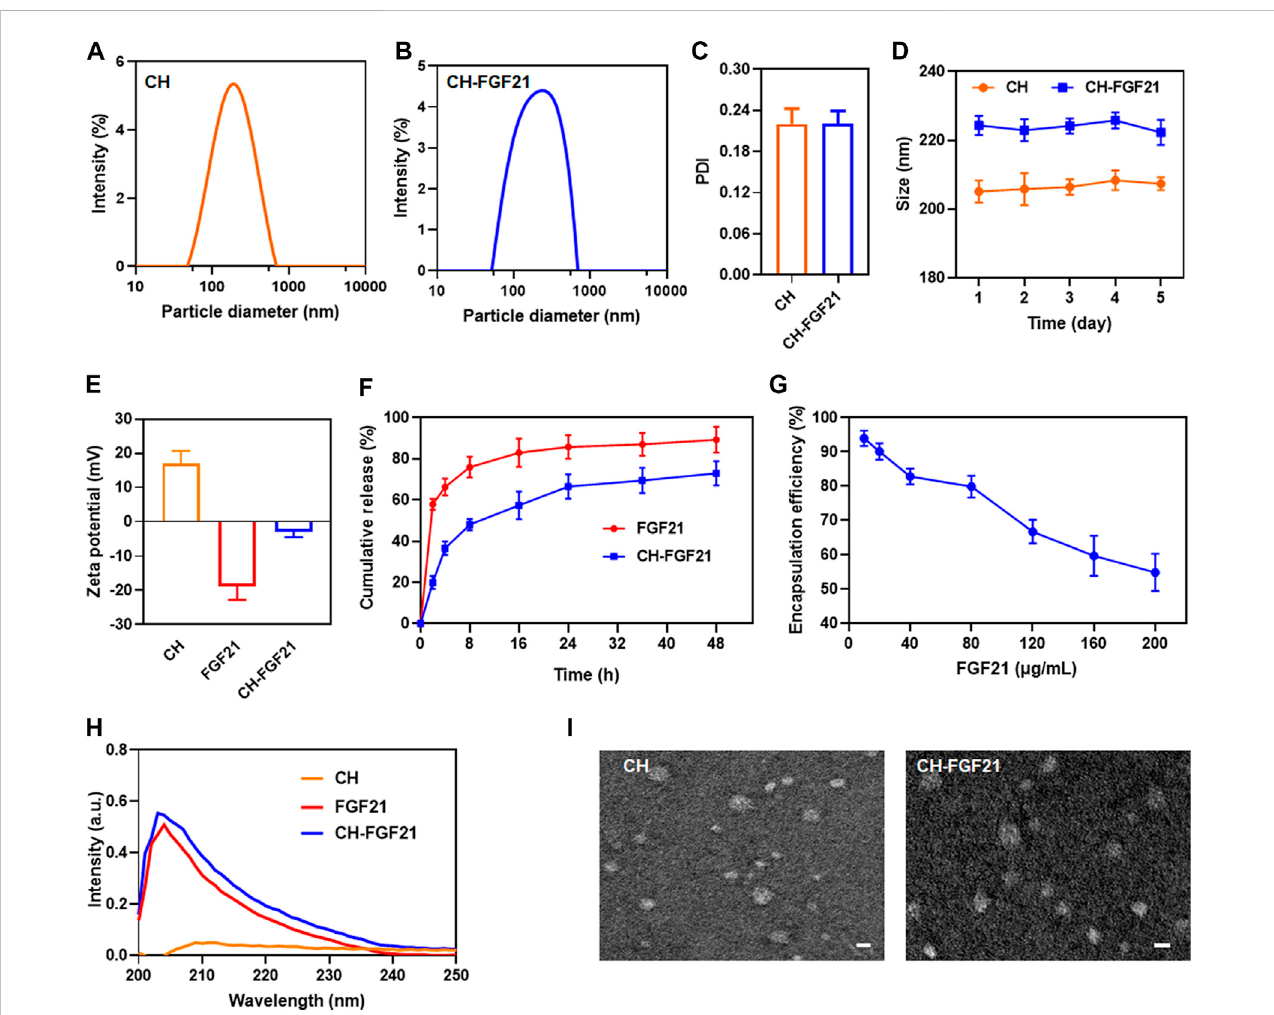
FIGURE 1 Characterization of CH-FGF21. The size distribution of (A) CH nanoparticles and (B) CH-FGF21. (C) Polydispersity index (PDI) of CH nanoparticles and CH-FGF21. (D) SizechangeofCHnanoparticlesandCH-FGF21over5 days. (E) ZetapotentialofCHnanoparticles,FGF21,andCH-FGF21. (F) Invitro releaseof FGF21 and CH-FGF21. (G) Encapsulation ef fi ciency of CH-FGF21. (H) Ultraviolet-visible (UV-vis) spectra of CH nanoparticles, FGF21, and CH-FGF21. (I) Transmission electron micrographs of CH nanoparticles and CH-FGF21. Scale bar = 200 μ m. Data are the mean ± SD ( n = 3). * p ≤ .05, ** p ≤